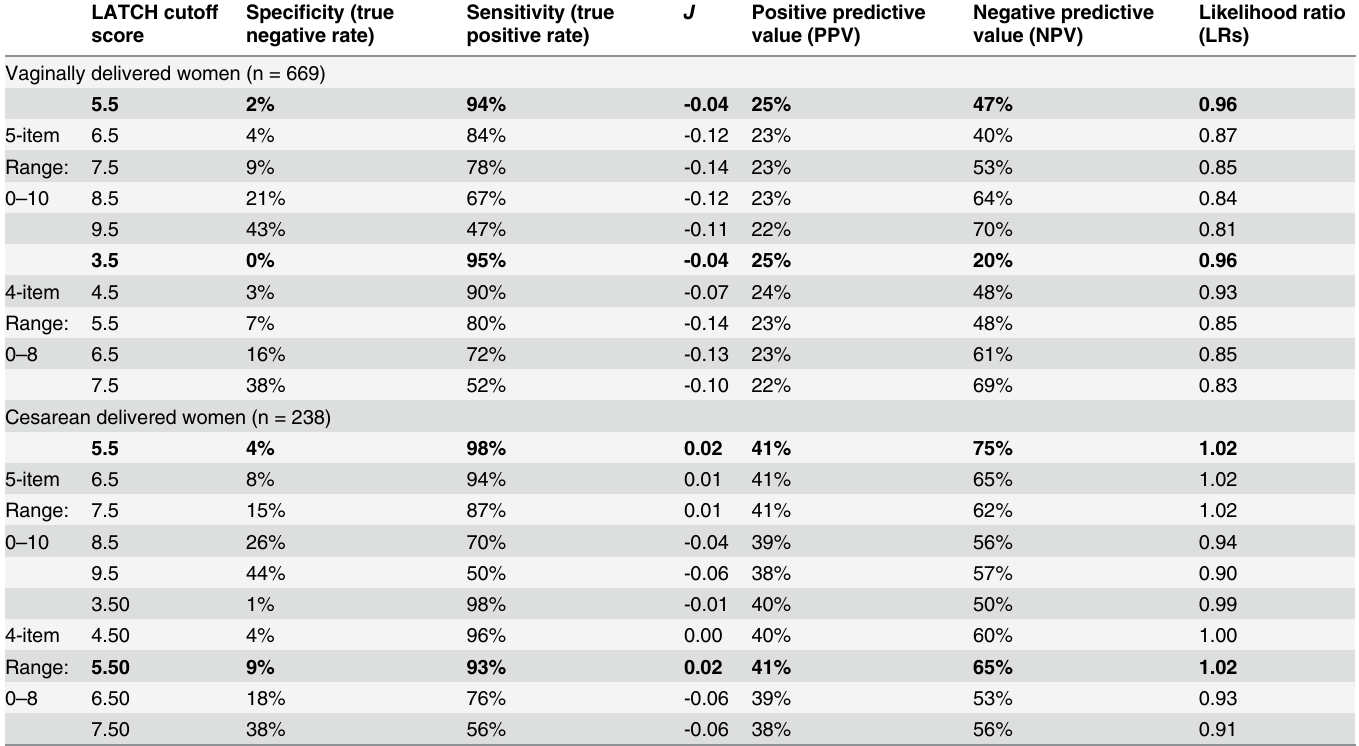
Table 3. Cutoff values of the 5- and 4-item LATCH breastfeeding assessment tools in detecting non-exclusive breastfeeding for vaginal (n = 669) and caesarean (n = 238) deliveries. LATCH cutoff